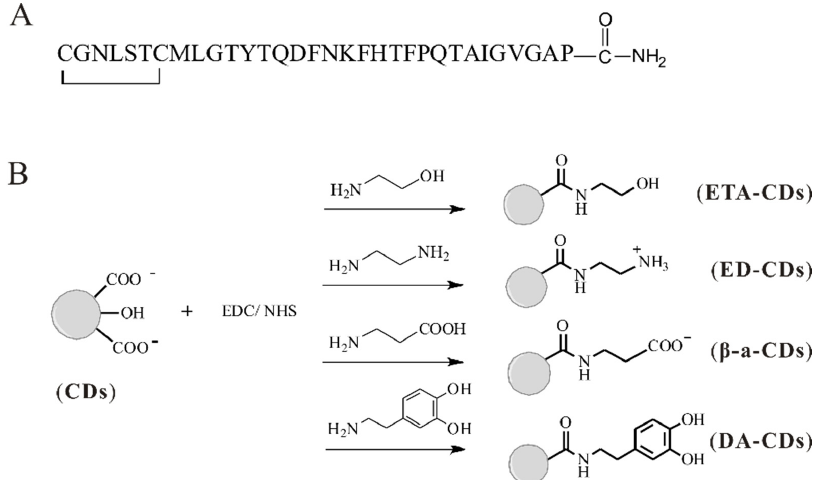
Figure 1. The primary sequence of hCT and schematic diagram of CDs synthesis. ( A ) hCT contains a disulfide bridge between residues 1 and 7, and the C-terminus is amidated. ( B ) A series of CDs with different functionality were obtained via modification of original CDs with different amine compounds by coupling reagents.